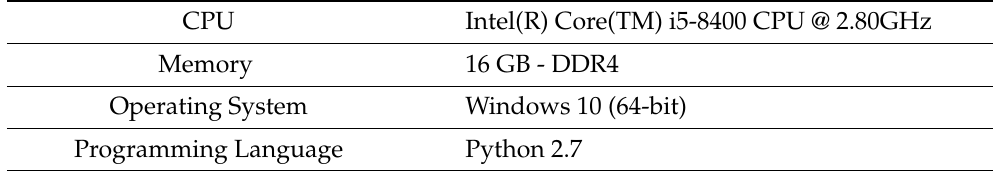
Table 2. Experimental environment.